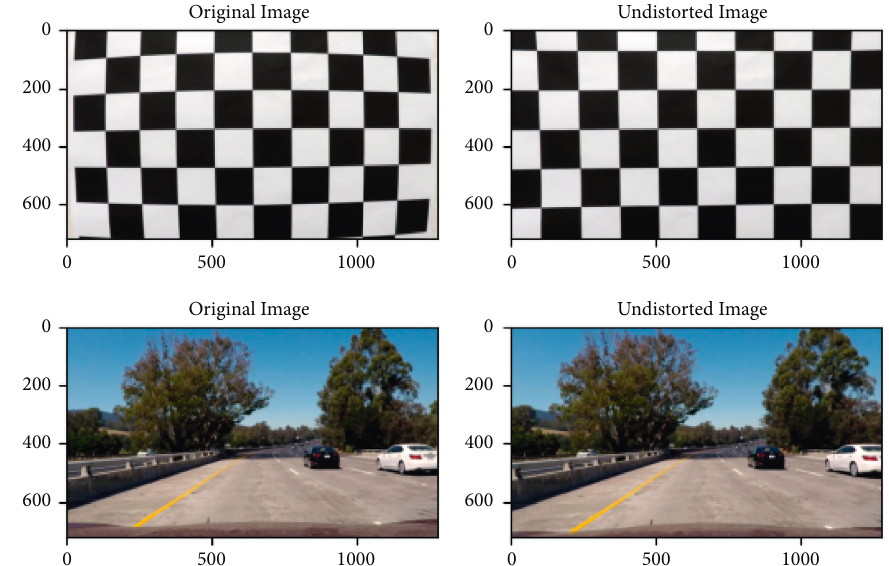
Figure 4: Result after removing image